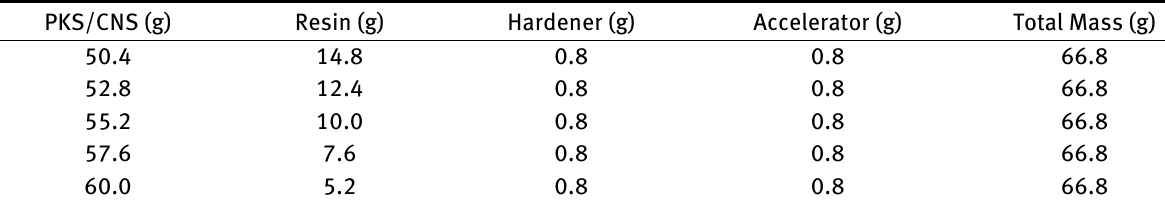
Table 1: Mass composition of the abrasive sandpaper composites PKS/CNS (g) Resin